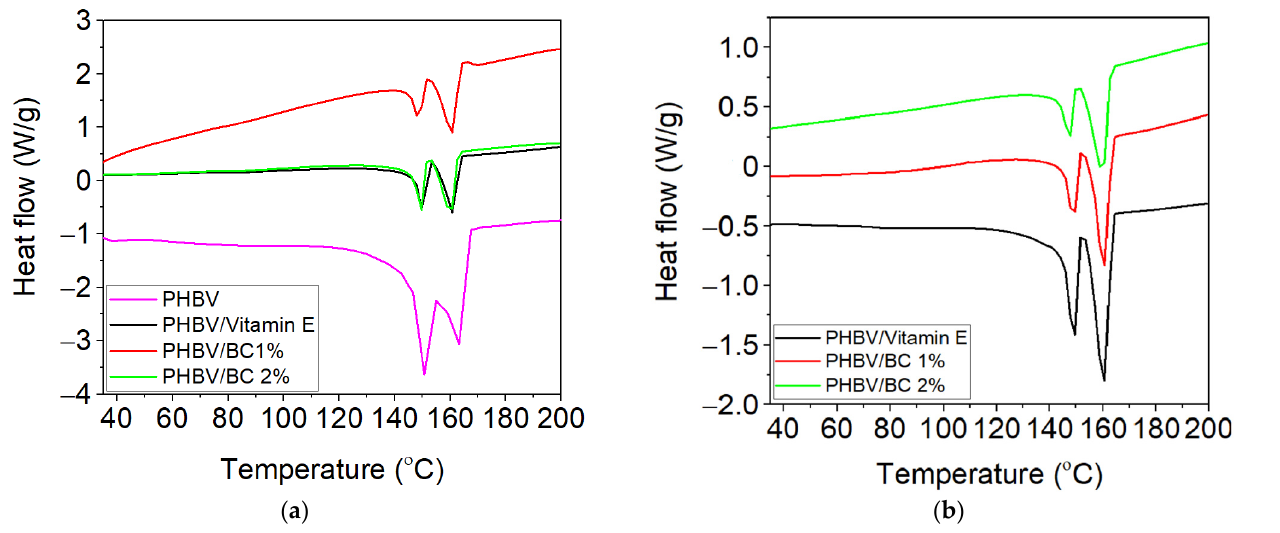
Figure 3. DSC curves for biocomposites based on PHBV, BC and vitamin E, first heating ( a ) initial; ( b ) after immersion for 30 days in PBS at 37 °C (exo up). Table 3. DSC parameters obtained for PHBV/BC biocomposites as compared with neat PHBV.